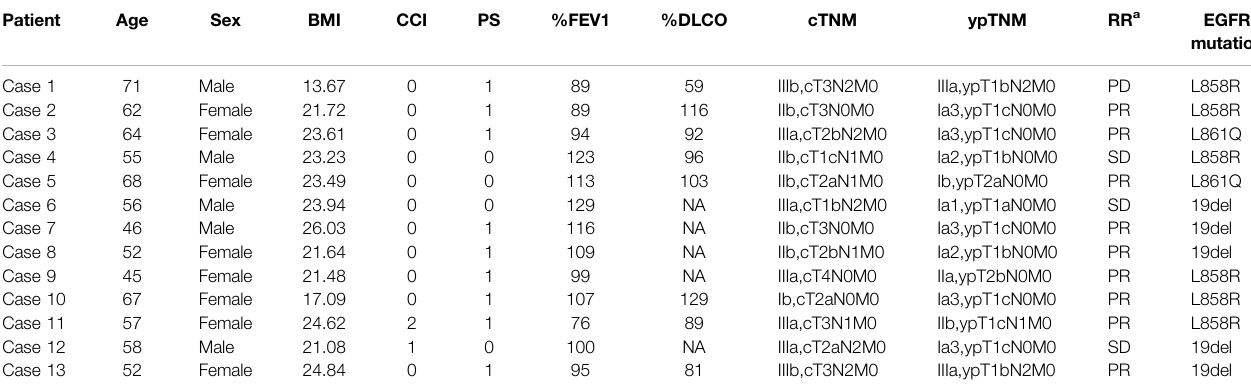
TABLE 1 | Patient characteristics.